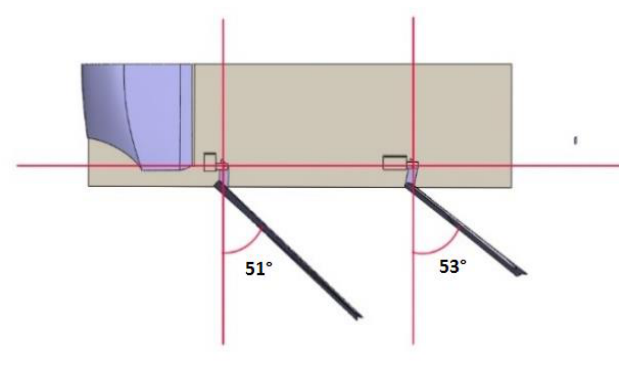
Fig. 12. Show setting of appropriate door